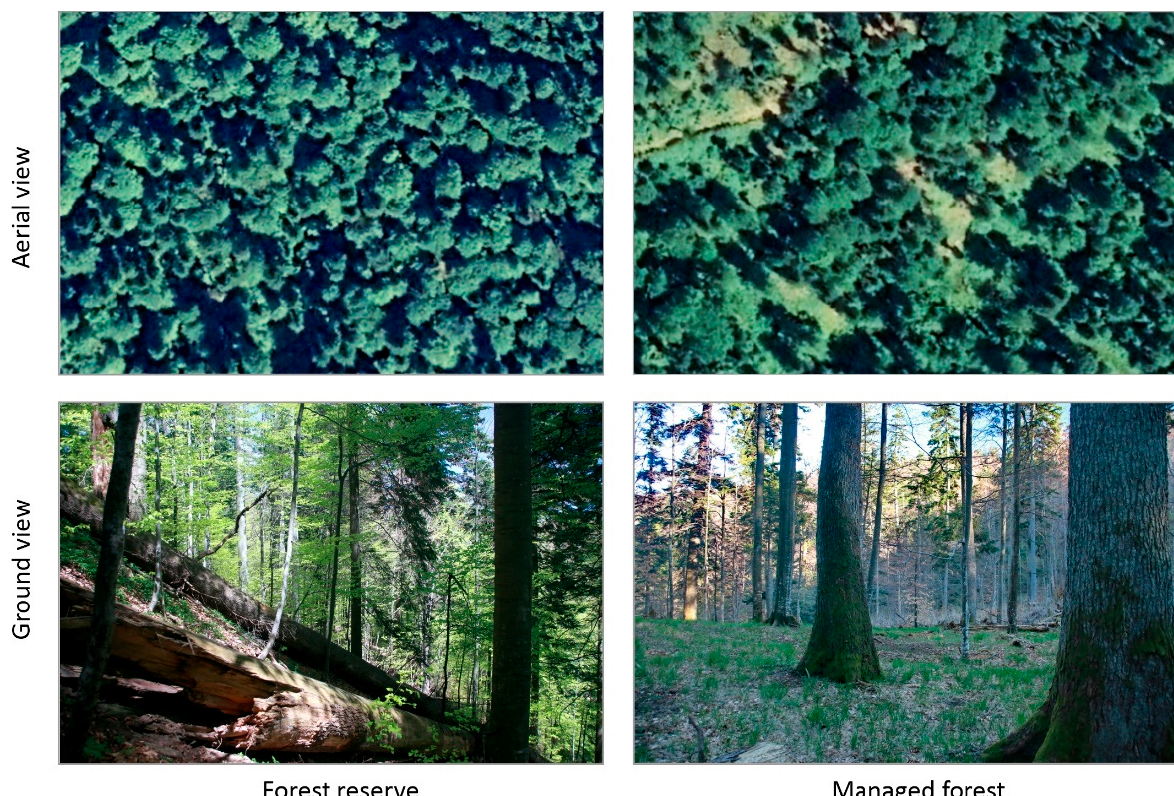
Figure 2. Aerial and ground views of forest reserve stand and managed forest stand (aerial images were taken from Google Earth).